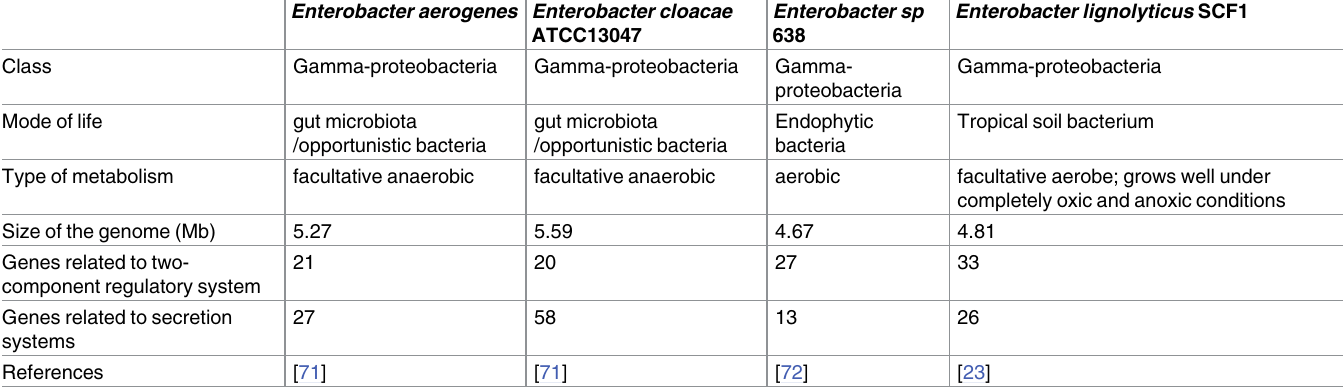
Table 2. Summaryof genome attributes of Enterobacter lignolyticus SCF1 and three close relatives, E . aerogenes , E . cloacae ATCC13047, and Enterobacter sp.